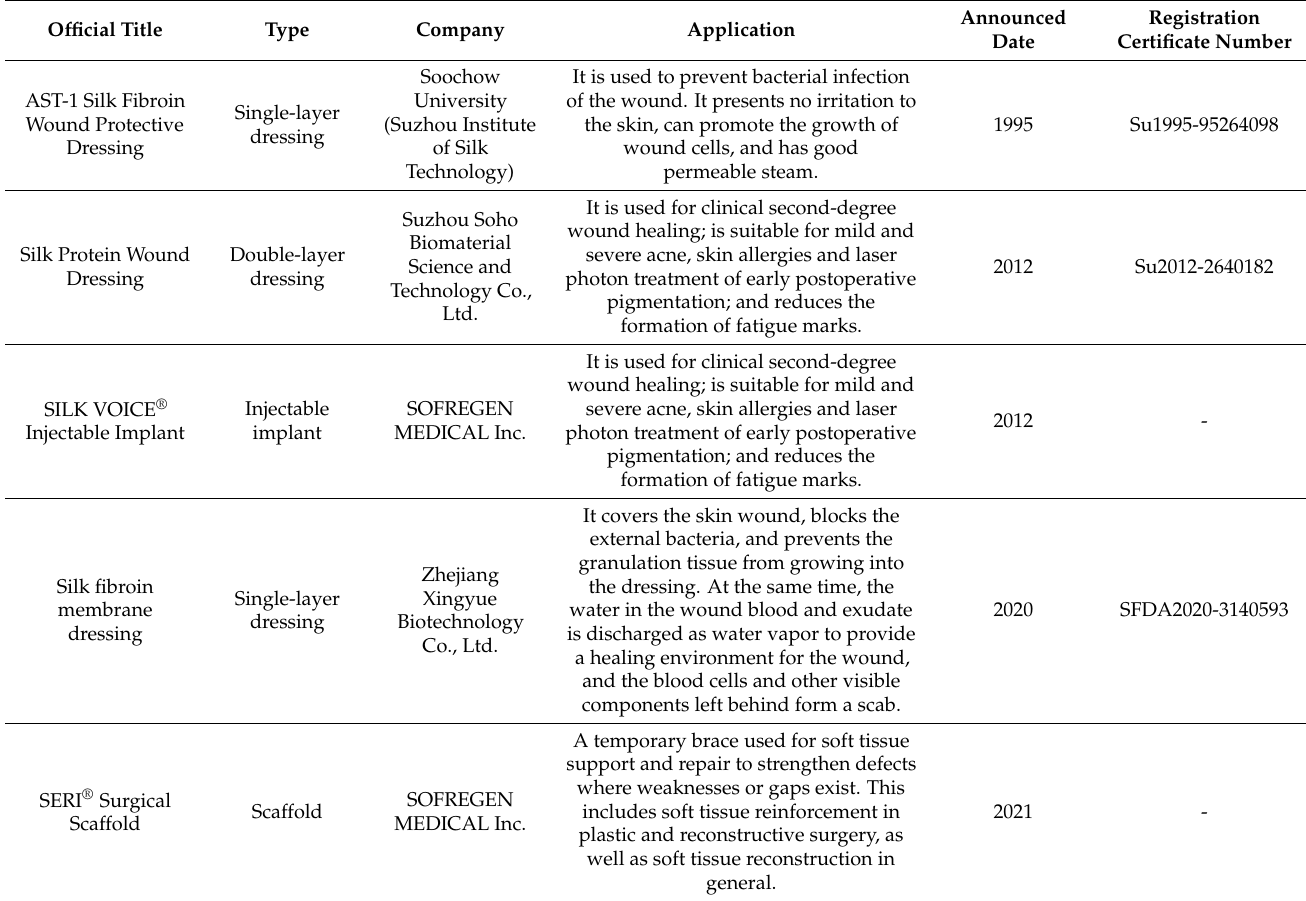
Table 1. Commercially available silk fibroin